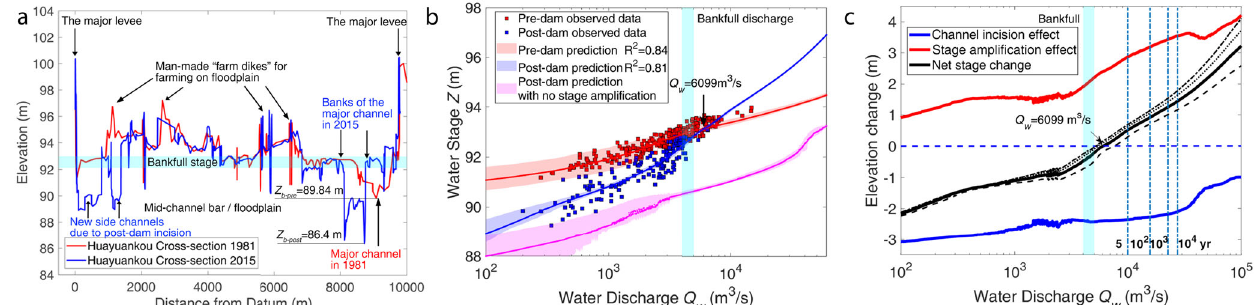
Fig. 5 Evaluation and comparison of the overall fl ood stage for pre-dam and post-dam conditions. a Cross-sectional pro fi les for pre-dam and post-dam conditions at the Huayuankou gauging station; b Pre- and post- dam fl ood stage and fl ood discharge. The red solid line is the theoretical prediction for the pre-dam fl ood stage based on observed cross-sections and Eq. 1 with C f from Fig. 4b (see Text “ Hydraulic prediction for the fl ow stage based on observed cross-sections ” in Methods), and the red shaded area indicates the 95% con fi dence interval of the prediction uncertainty induced by the pre-dam cross- section variation. The blue solid line is the theoretical prediction for the post-dam fl ood stage, with the blue shaded area indicating the 95% con fi dence interval of the prediction uncertainty induced by the post-dam cross-section variation. The pink solid line is the theoretical prediction for the post-dam fl ood stage based on the post-dam cross-sections (including considerations of channel widening and bed incision) without consideration of the stage ampli fi cation effect (grain size and bedform size unchanged). c Water stage elevation changes produced by various effects. The blue solid line represents the stage elevation change induced solely by channel incision (enlargement) without consideration of the stage ampli fi cation effect. The red solid line represents the stage ampli fi cation effect. The black solid line represents the net effect of stage ampli fi cation effect and channel enlargement effect ( D 50 = 0.30 mm). The black lines from right to left (dash, solid, dot, dot-dash) represent D 50 = 0.25, 0.30, 0.35, 0.40 mm, respectively. Correspondingly, the crossing-point discharges, where post-dam stages surpass the pre-dam values, are 7571, 6099, 5469, and 5164 m 3 s − 1 , respectively. Coarser beds lead to a smaller crossing-point discharge. Dot-dash vertical lines represent the fl ood discharges at different recurrence intervals (5, 10 2 , 10 3 , 10 4